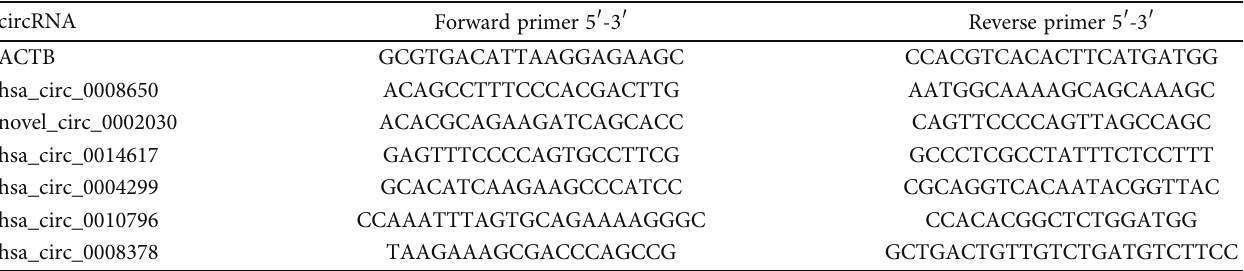
Table 1: Primers used for circRNA expression analysis.